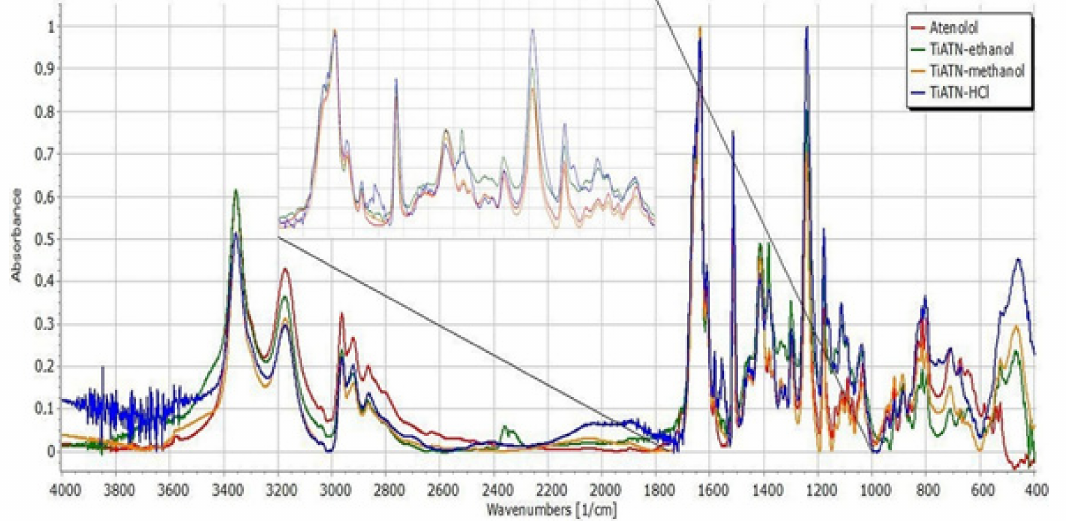
Figure 5. FT-IR spectra of atenolol, TiATN–ethanol, TiATN–methanol, and TiATN–HCl 0.01